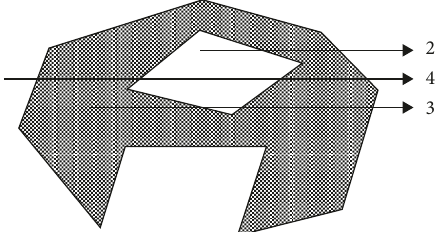
Figure 6: Ship position simulation diagram.